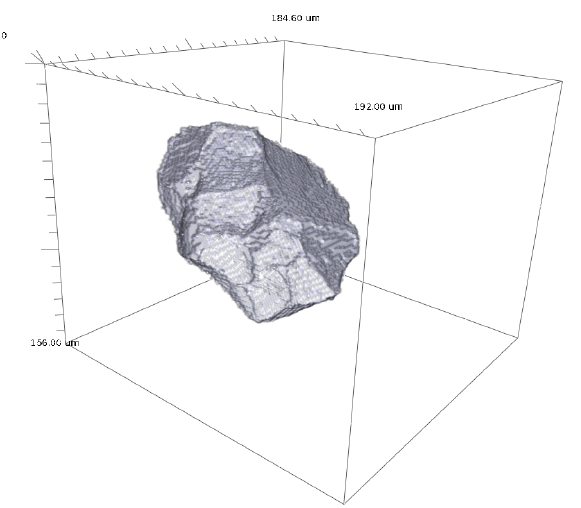
Figure 16. Rendering of a non-convex grain observed in the DCT data of the titanium sample. Table 4. Results for the titanium model realizations (cv s = 2.34 and 17,344 cells).